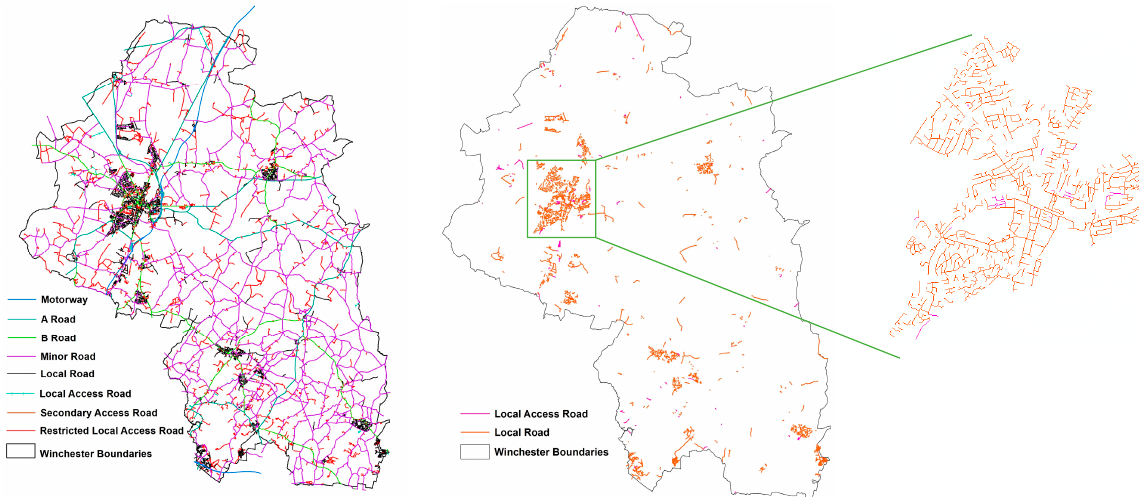
Figure 3. All road types in Winchester District ( left ), and remaining potential road segments follow the initial three exclusion criteria ( right ). The square in the lower figure shows Winchester City’s local roads.